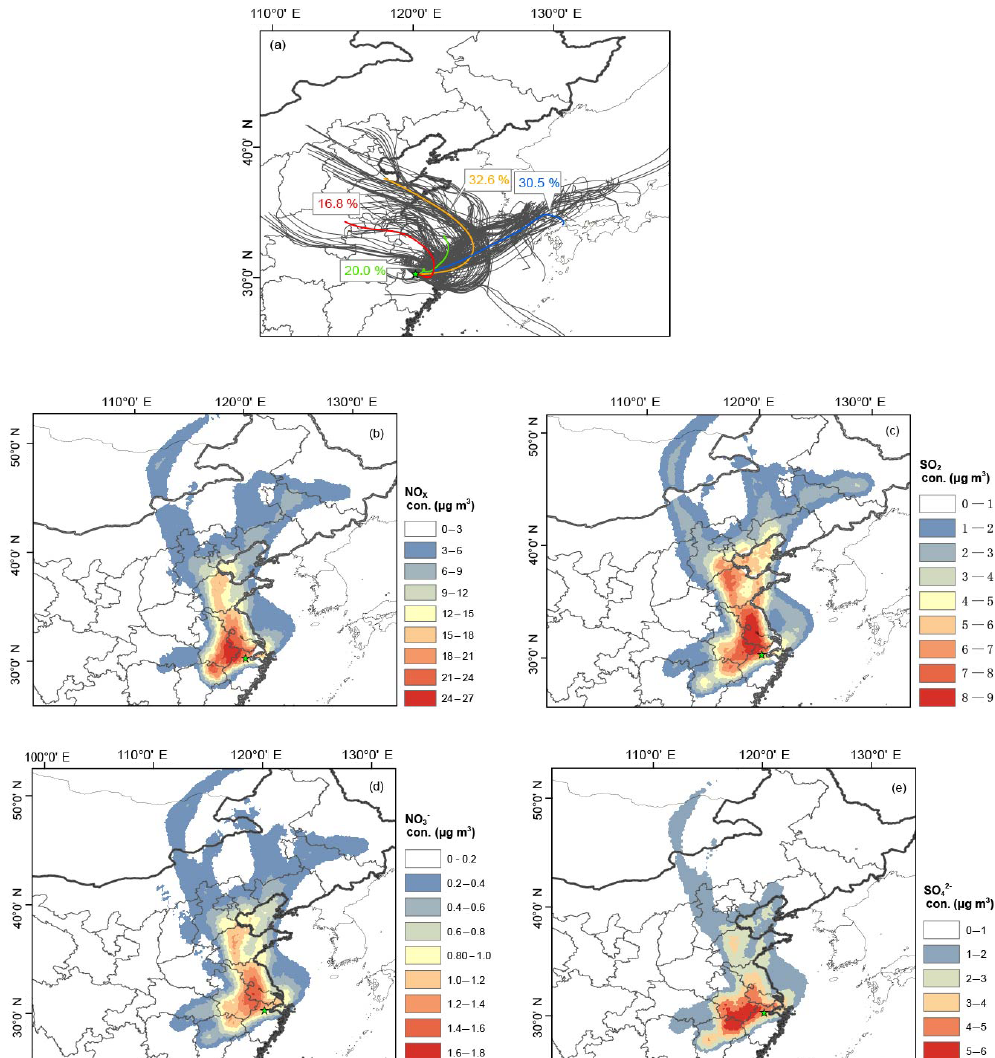
Figure 6. (a) Cluster analysis of the 72h air mass backward trajectories starting at 500m in Hangzhou during S3. Concentration weighted trajectory (CWT) maps for (b) NO x , (c) SO 2 , (d) NO − by a green